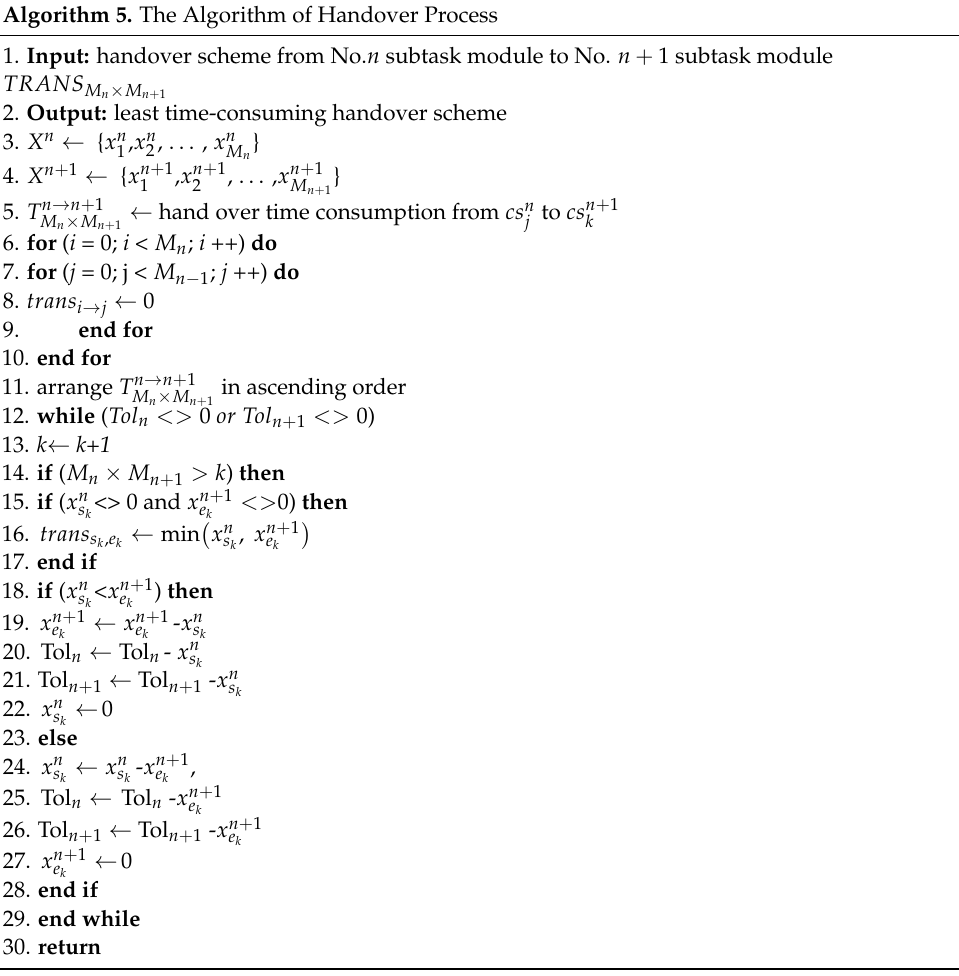
Algorithm 5. The Algorithm of Handover